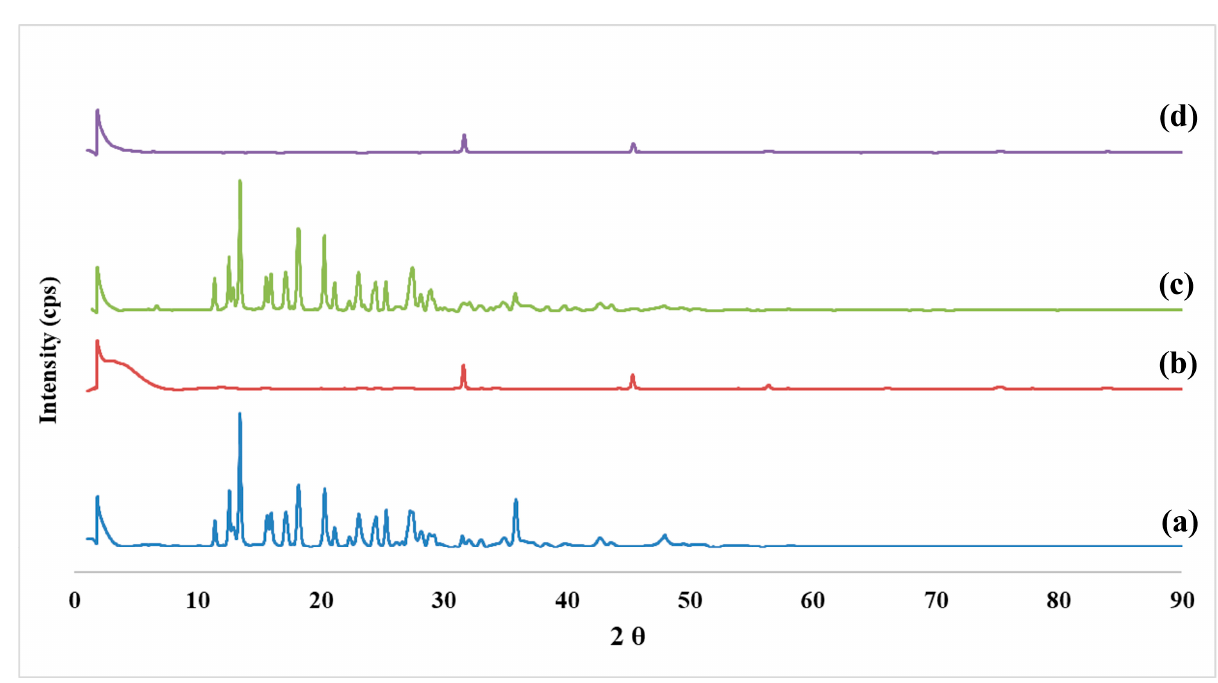
Figure 6. XRD pattern of ( a ) PMZ, ( b ) Arg-PA, ( c ) the PMZ- Arg-PA physical mixture, and ( d ) PMZ- Arg-PA NCs.